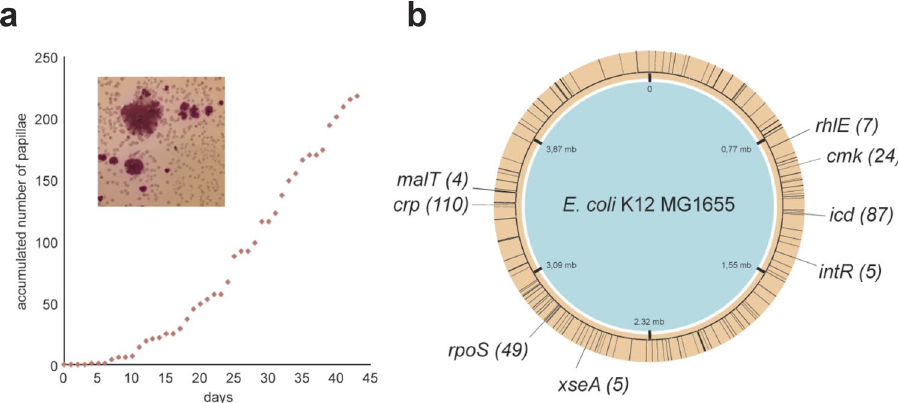
Figure 2. When subjected to prolonged incubation, Escherichia coli K12 MG1655 cyaA - cells adapt to their environment. ( a ) E. coli cyaA- cease to grow after forming small white colonies, when maltose is the major carbon source. After 4–5 days of incubation, mutants start occurring as red papillae on MacConkey agar (inserted image) and continue to form over approximately 6 weeks. Mutant papillae outgrew on approximately one in 200 colonies. ( b ) 96 mutant papillae were isolated, phenotypically characterized and genome sequenced. Loci with less than three mutations are uniformly distributed on the circular genome as illustrated with black lines. Hotspots of genes with more than two mutations are indicated with double-sized black lines and the total number of mutations in each gene is stated within